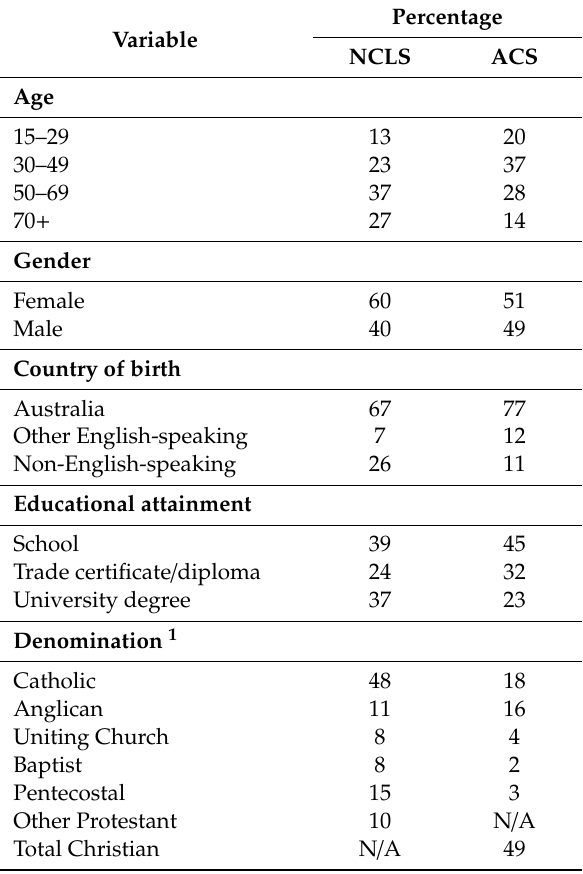
Table 2. Demographics of National Church Life Survey (NCLS) and Australian Community Survey (ACS)